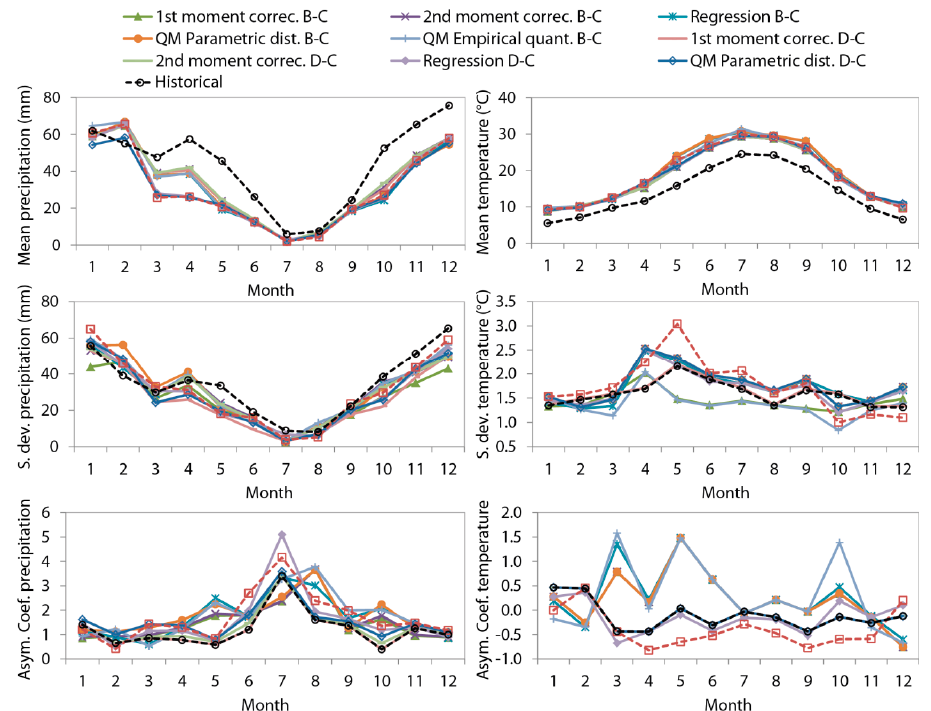
Figure 9. Mean, standard deviation and asymmetry coefficients of future precipitation ( left column) and temperature series ( right column). Average year for HIRHAM5 RCM model nested inside EC-EARTH GCM—lumped approaches.